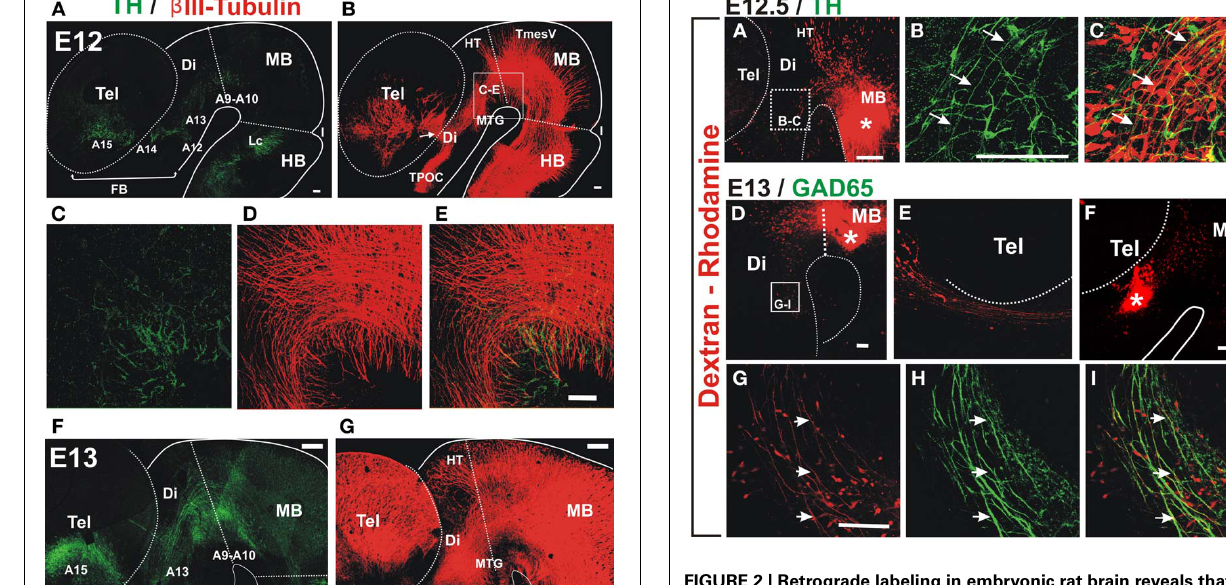
FIGURE 2 | Retrograde labeling in embryonic rat brain reveals that ascending TH axons interact with descending GAD65 axons. Dextran-Rhodamine was applied at the locations indicated by asterisks in E12.5 (A) and E13 (D,F) rat embryos (red) and whole brains were immunostained for TH ( B,C , green) or GAD65 ( H,I , green). Flat-mounted hemibrains are shown. (A,D–F) are panoramic views; (B,C) show a magnified view of the frame indicated in (A) revealing apposition of descending Dextran-labeled axons with ascending TH axons (example axon indicated by three arrows). (F) shows dextran labeling in the diencephalon at the DA axon entry point into the telencephalon and (E) shows the rostral region of the same preparation revealing neurons with descending axons. (G–I) are magnified views of the frame indicated in (D) and show colocalization of GAD65 signal (green) with all Dextran-labeled axons (red, examples indicated by arrows) consistent with expression of GAD65 in descending axons. Abbreviations as in Figure 1 . Scale bars: 100 μ